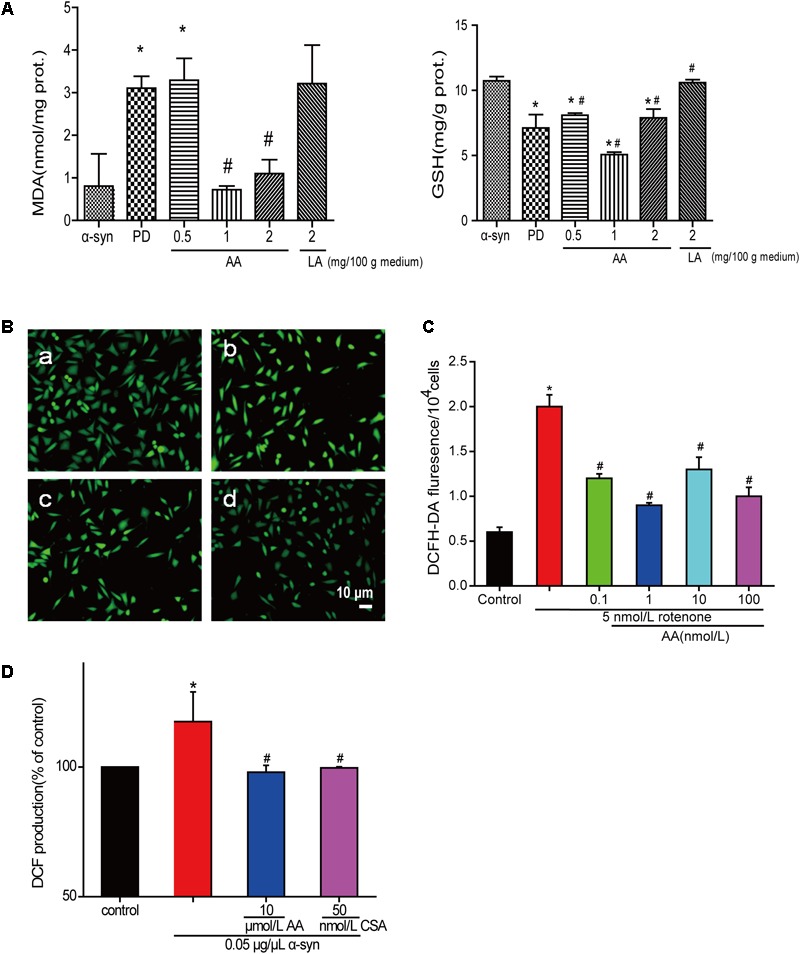
AA reverses PD-like oxidative stress. (A) Effects of AA on the activities of MDA and GSH in α-syn transgenic PD drosophila. Control and a-syn transgenic PD Drosophila were divided into indicated groups, and they all collected at DAY 36. The level of MDA and GSH in supernatant of drosophila homogenate were detected by kits. (mean ± SD, n = 3, ∗p < 0.05 vs. normal control group after treatment with different concentrations of AA or LA). (B,C) Intracellular ROS levels were determined based on DCF fluorescence under an inverted fluorescence microscope and on a spectrofluorometer. SH-SY5Y cells were treated with 5 nM rotenone exposure for 4 weeks and then various concentrations of AA after 24 h. a: control; b: 5 nmol/L chronic rotenone; c: 1 μM AA; d: 10 μM AA. Bar: 10 μm. Data are expressed as means ± SD, n = 3. ∗p < 0.01 vs. control group, #p < 0.01 vs. rotenone group. (D) Effects of AA on α-syn induced mitochondrial ROS formation (DCF production). Isolated mitochondria dyed with DCFH-DA were treated with vehicle or AA for 60 min at 37°C and exposed to 0 or 0.05 μg/μL α-syn at the same time. 60 min later fluorescence were detected on a spectrofluorometer. Data are expressed as means ± SD, n = 3. ∗p < 0.01 vs. control group, #p < 0.01 vs. α-syn group.